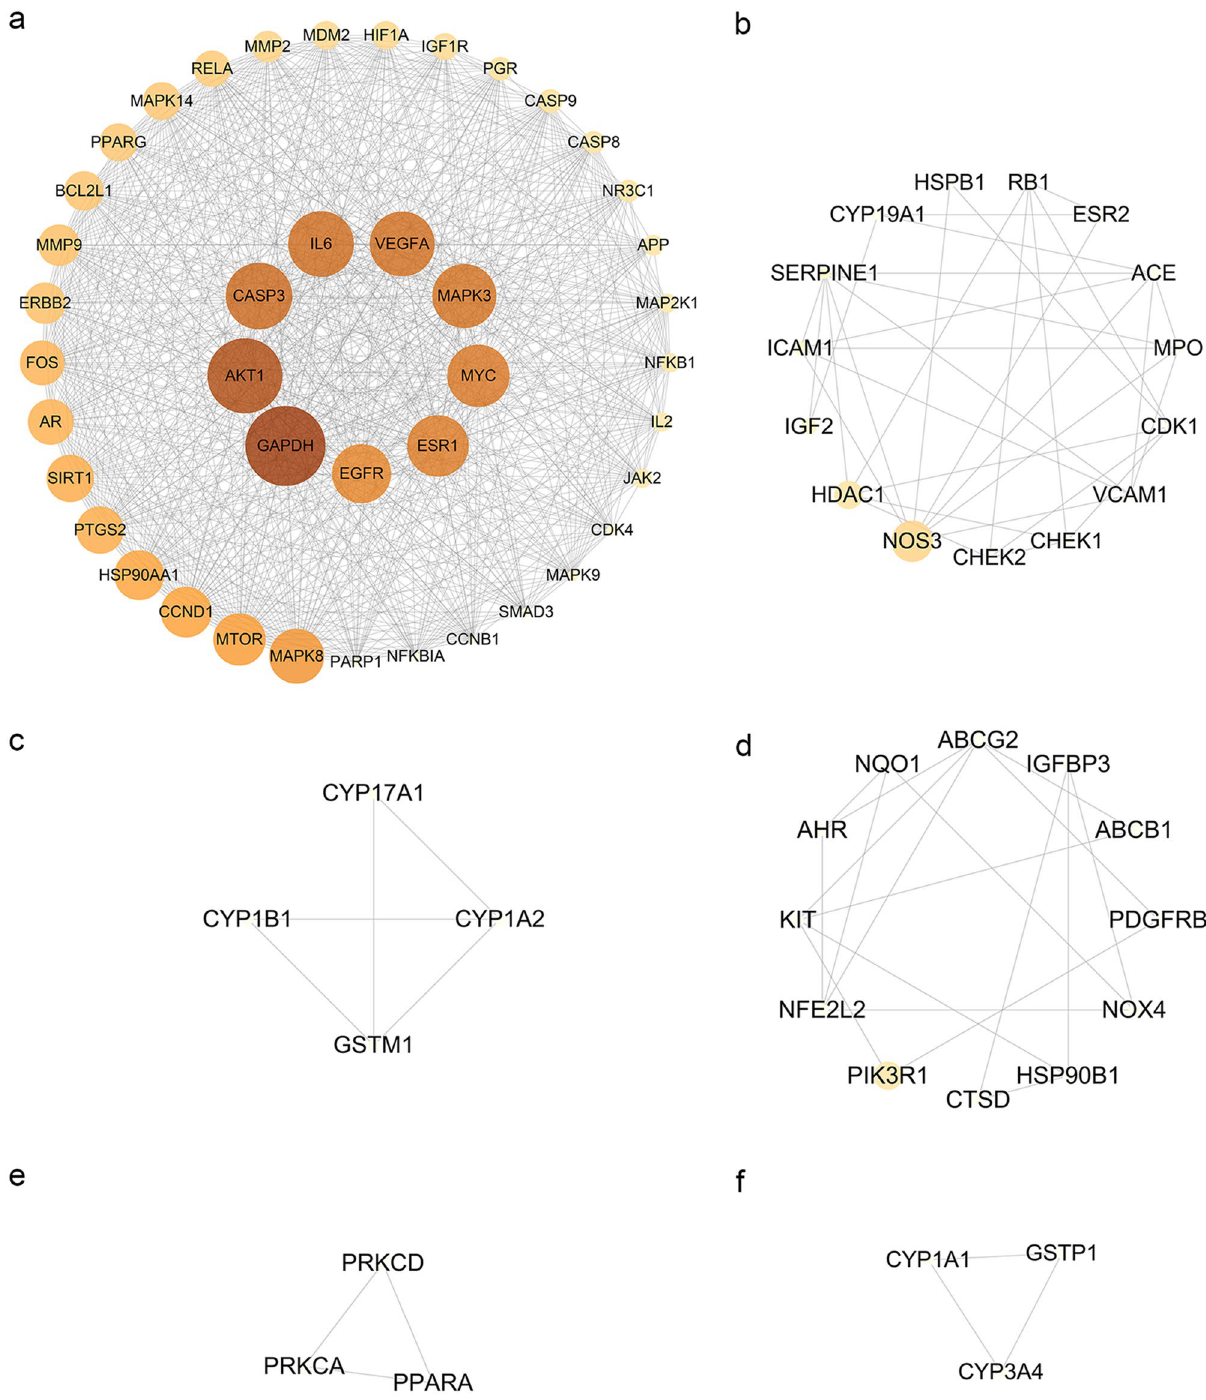
Figure 5. Cluster analysis of MOLBCH-OA PPI Network. ( a ) Cluster 1, composed of 42 nodes and 724 edges (score = 35.317). ( b ) Cluster 2, composed of 15 nodes and 34 edges (score = 4.857). ( c ) Cluster 3, composed of 4 nodes and 5 edges (score = 3.333). ( d ) Cluster 4, composed of 12 nodes and 18 edges (score = 3.273). ( e ) Cluster 5, composed of 3 nodes and 3 edges (score = 3). ( f ) Cluster 6, composed of 3 nodes and 3 edges (score = 3). The nodes stand for the target protein of MOLBCH on OA. The color scales and the size of the circle represent the node degree of the target